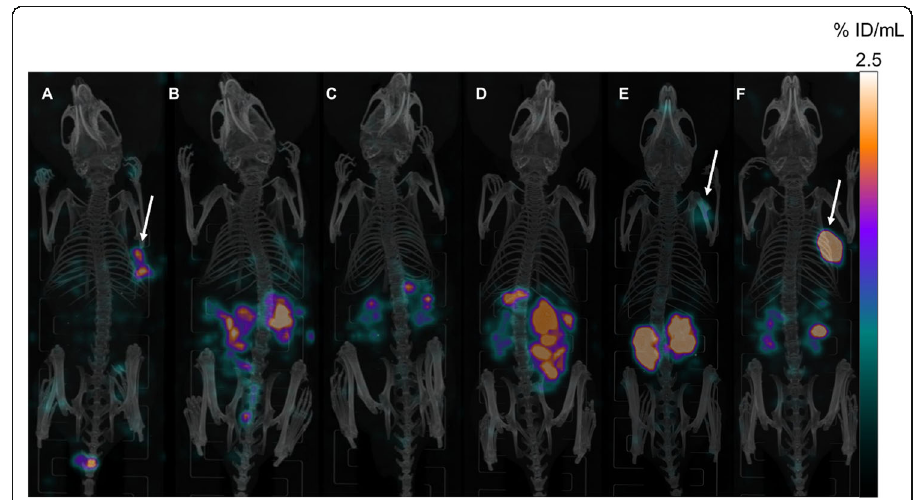
Fig. 6 Maximum intensity projections (MIPs) of μ SPECT/CT scans in LNCaP xenograft-bearing mice,